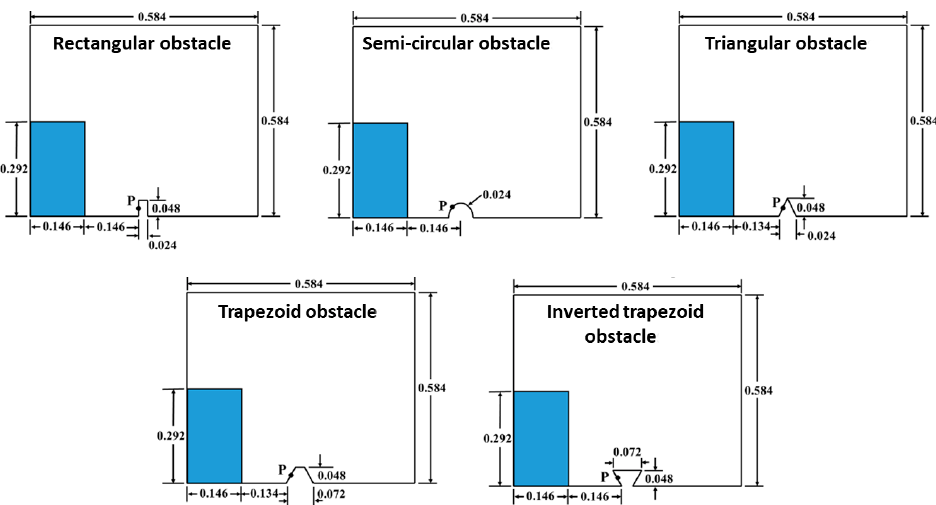
Figure 5. Calculation models of di ff erent